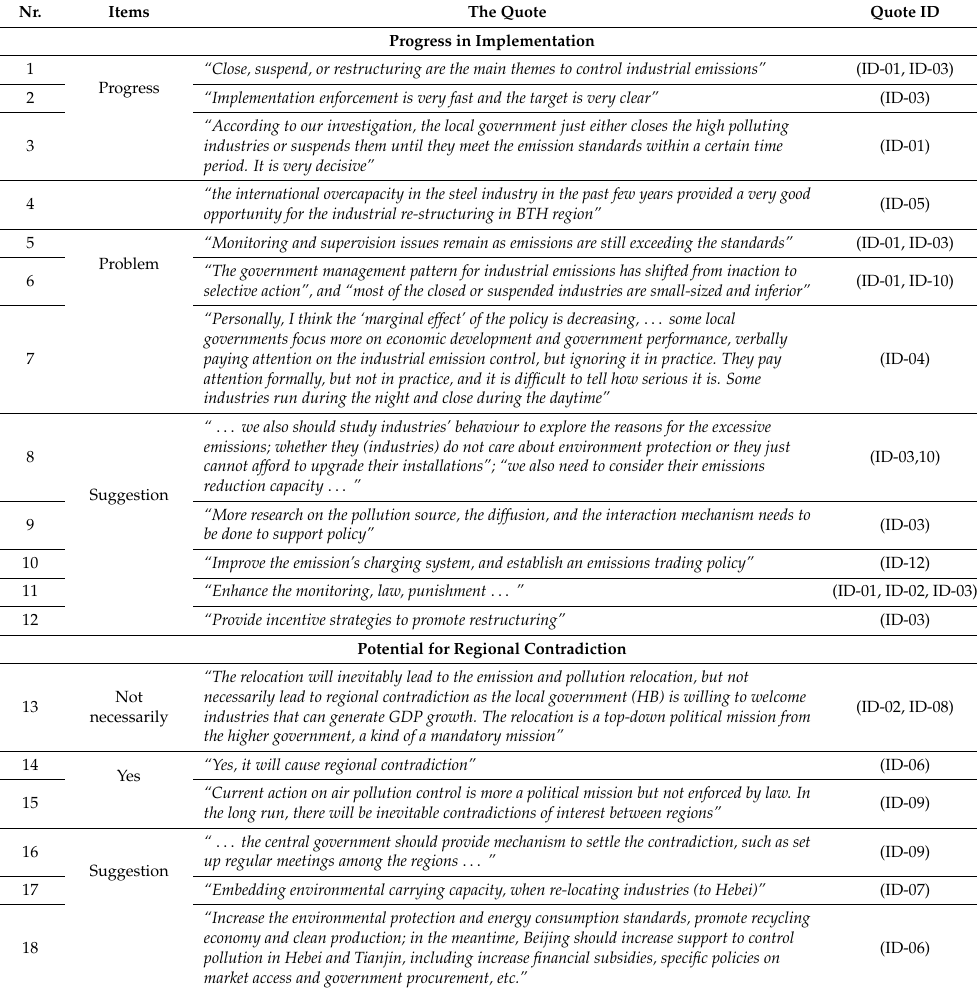
Table 1. Interview quotes on industrial restructuring and related emission